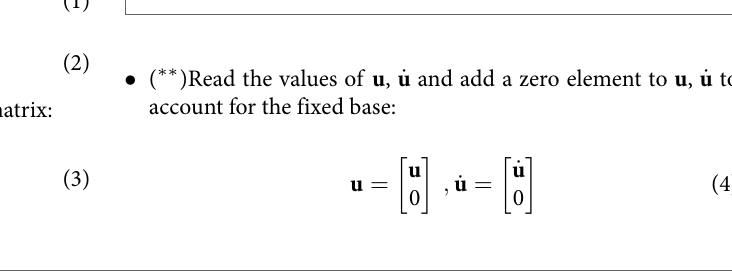
FIGURE 2 | Force-displacement diagram showing one cycle of the bilinear elastic model used in this study.